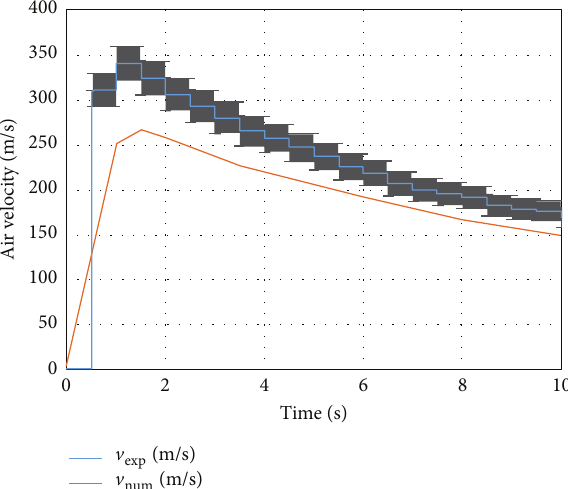
Figure 6: Local air velocity inside the STARDUST facility in the first 10